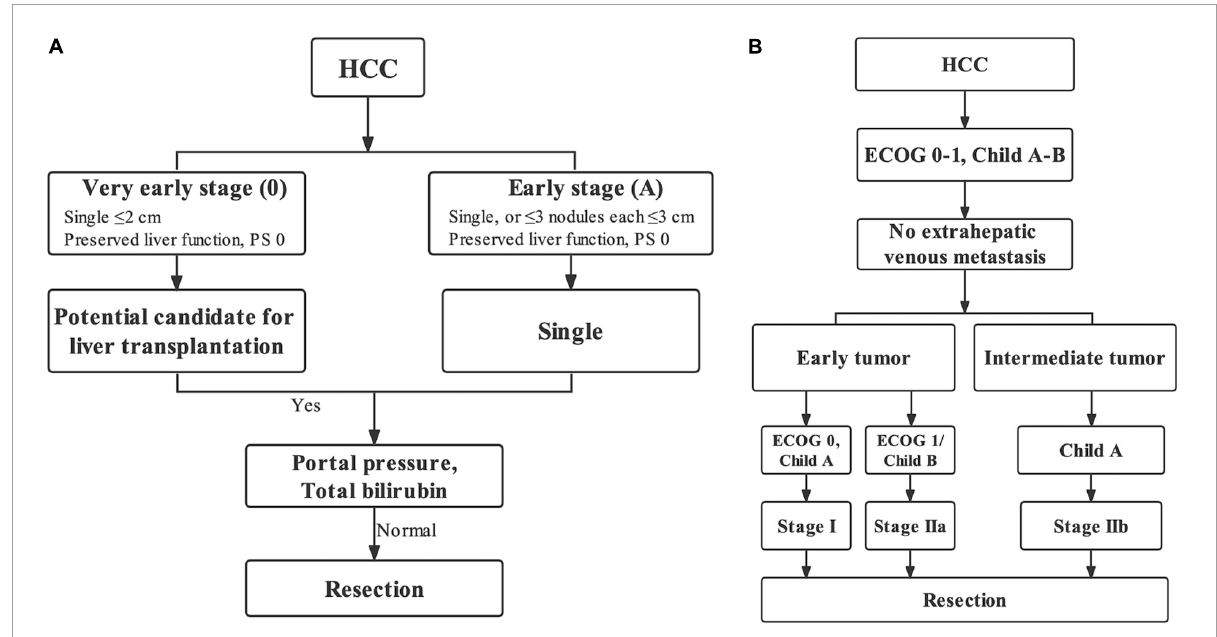
FIGURE2 Ideal patients for liver resection (IPLR) in the BCLC staging system (A) and HKLC staging system (B)